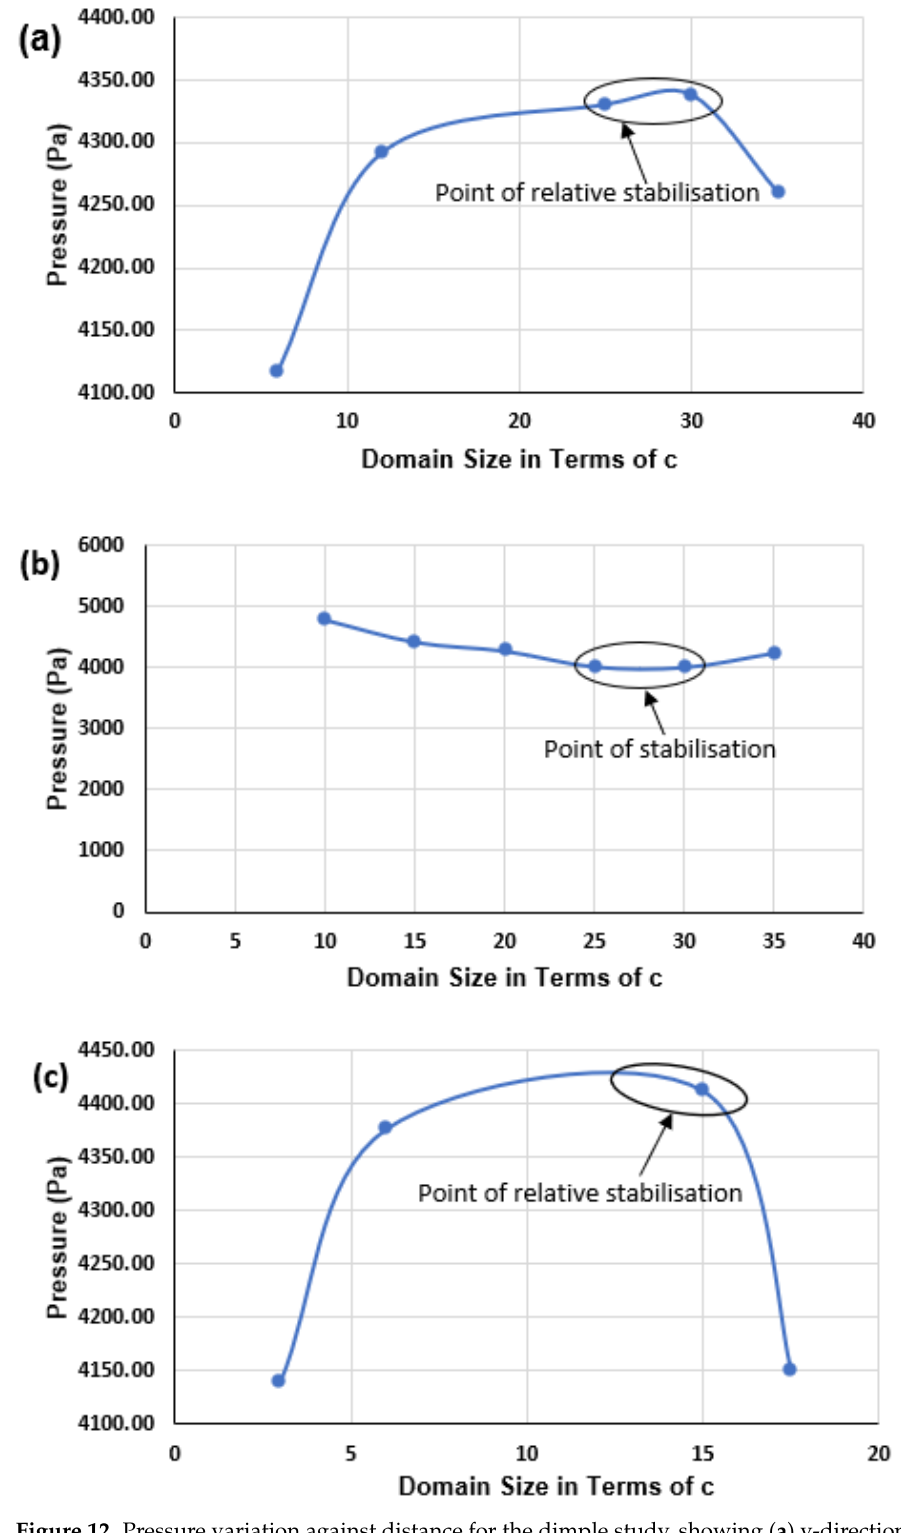
Figure 12. Pressure variation against distance for the dimple study, showing ( a ) y-direction stabilization point, ( b ) front-aerofoil stabilization points, and ( c ) behind-aerofoil stabilization points.